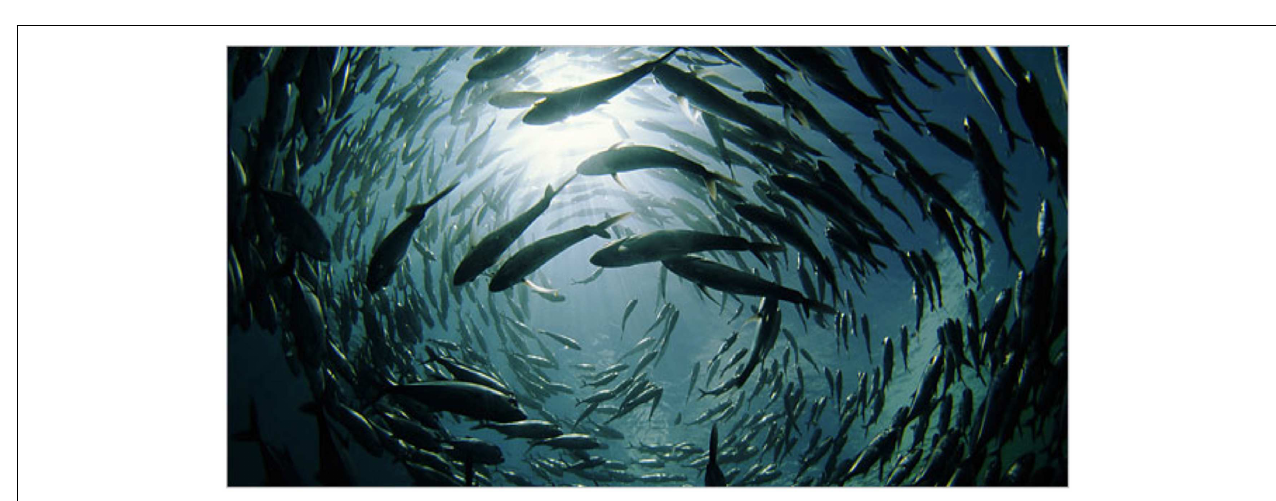
FIGURE 6 | Self-organization and swarm